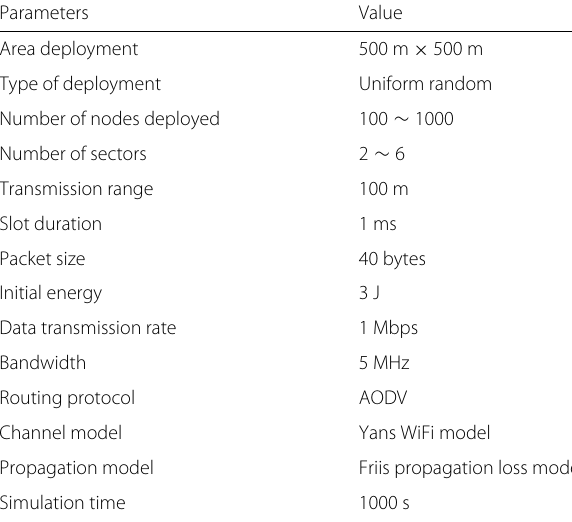
Table 2 Simulation